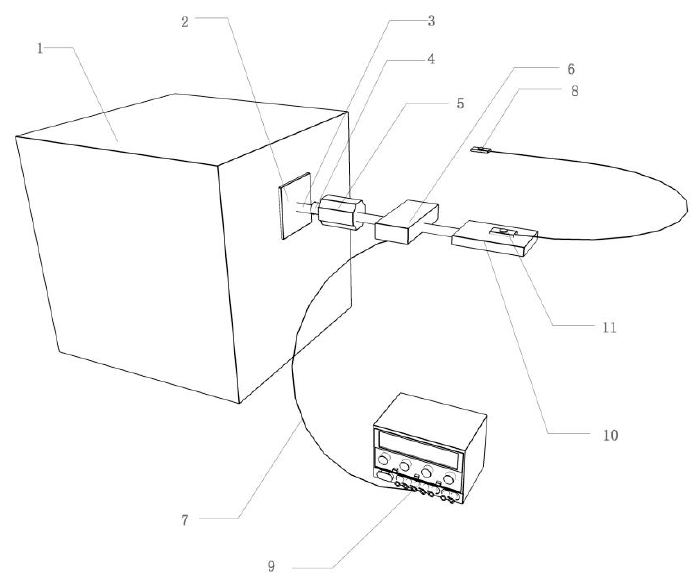
Figure 2. Design drawing of the experimental device.